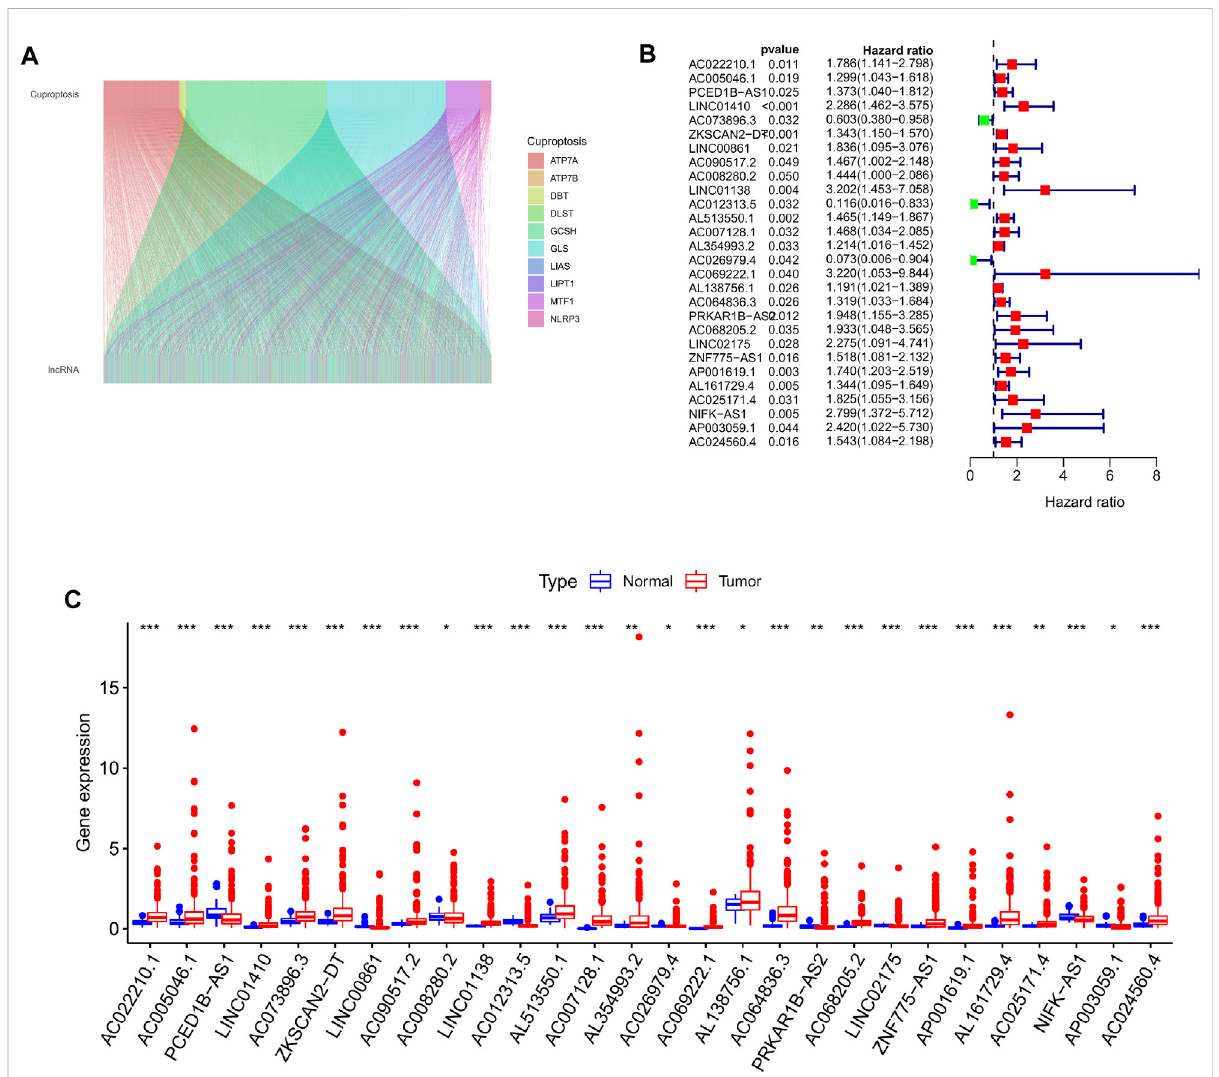
FIGURE 1 Screening for cuproptosis-related lncRNAs with prognostic differences. (A) Mulberry plot showing the co-expression of cuproptosis-related genes and lncRNAs. (B) 28 prognostic differential lncRNA forest maps were drawn based on the univariate Cox regression results. (C) Boxplot showing the differential expression of 28 lncRNAs with prognostic differences in tumor tissue and normal